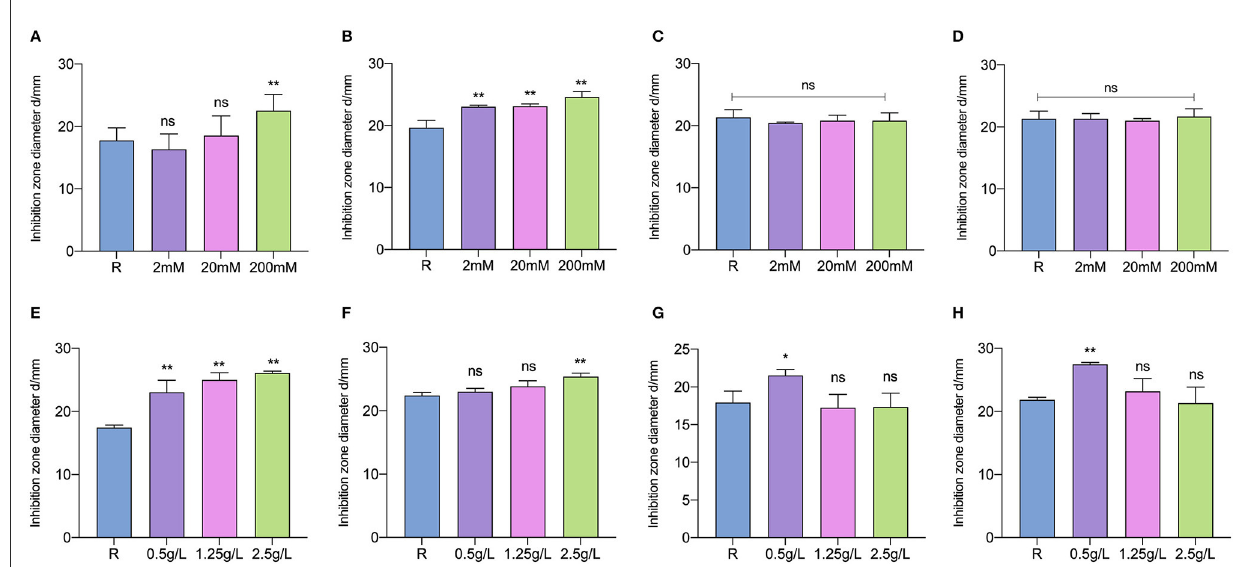
FIGURE7 Inducing effects of different concentrations of galactose (A) , mannose (B) , cellobiose (C) , D-ribose (D) , arginine (E) , cysteine (F) , glutamate (G) , and glutamine (H) on plantaricin production. ns: not significant, * p < 0.05, ** p < 0.01.